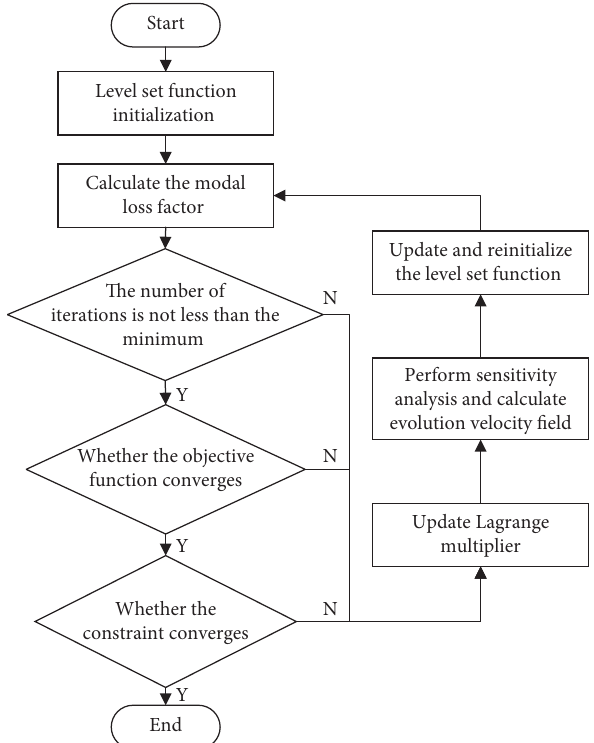
Figure 5: Flow chart of the parameterized level set method for optimizing the modal loss